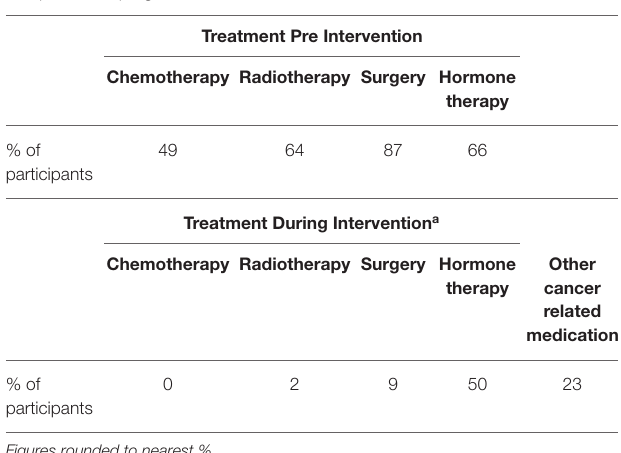
TABLE 1 | Treatments Pre and During Intervention per % of women who completed the